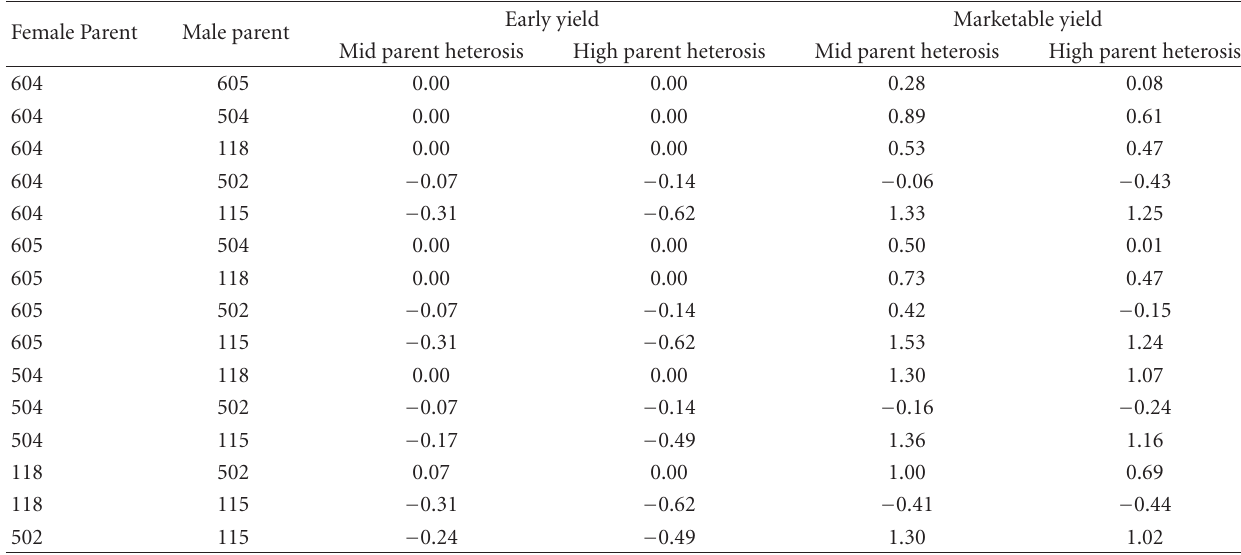
Table 5: High parent heterosis and mid parent heterosis for early yield and marketable yield.